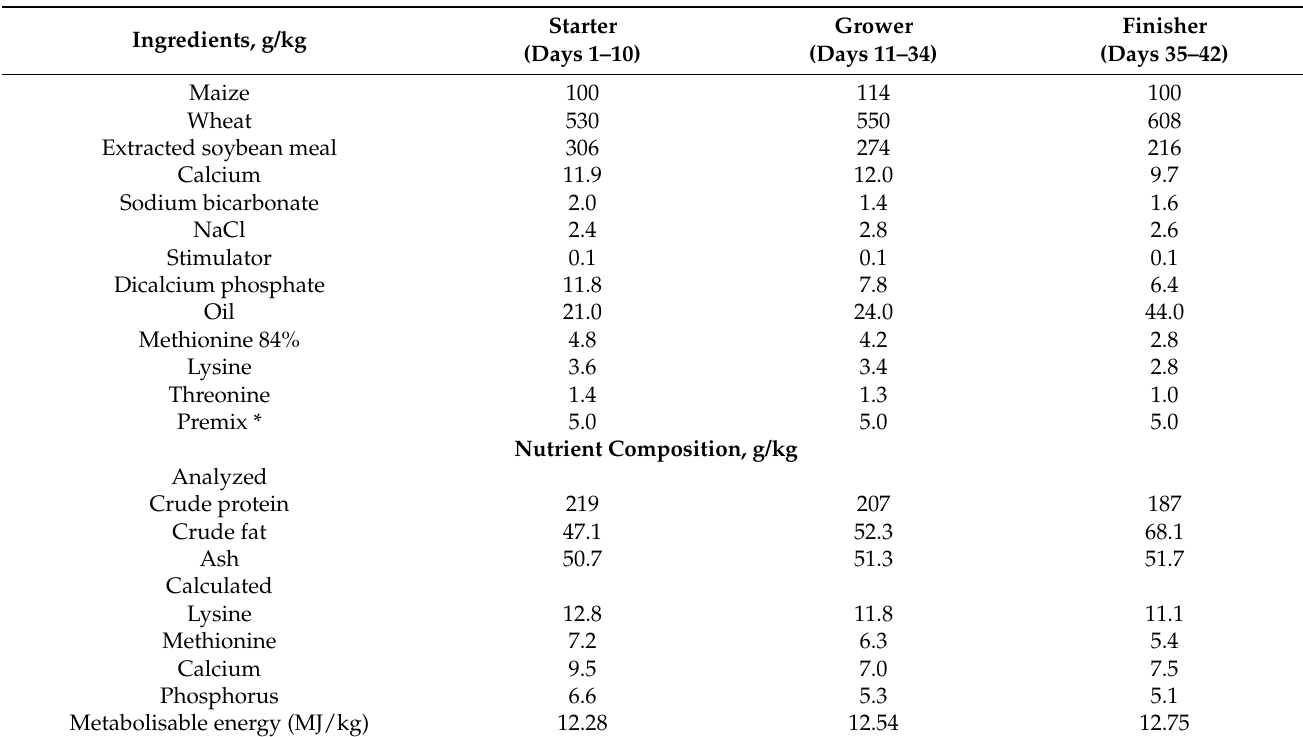
Table 1. Components and chemical composition of the broiler chicken